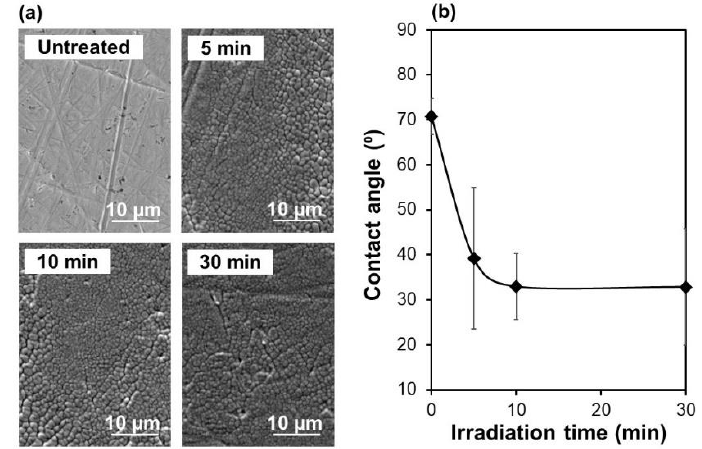
Figure 5. ( a ) SEM images and ( b ) contact angles of water droplets of the surfaces of the Co − Cr alloy substrates after laser irradiation in ultrapure water for 0 (untreated), 5, 10 and 30 min.